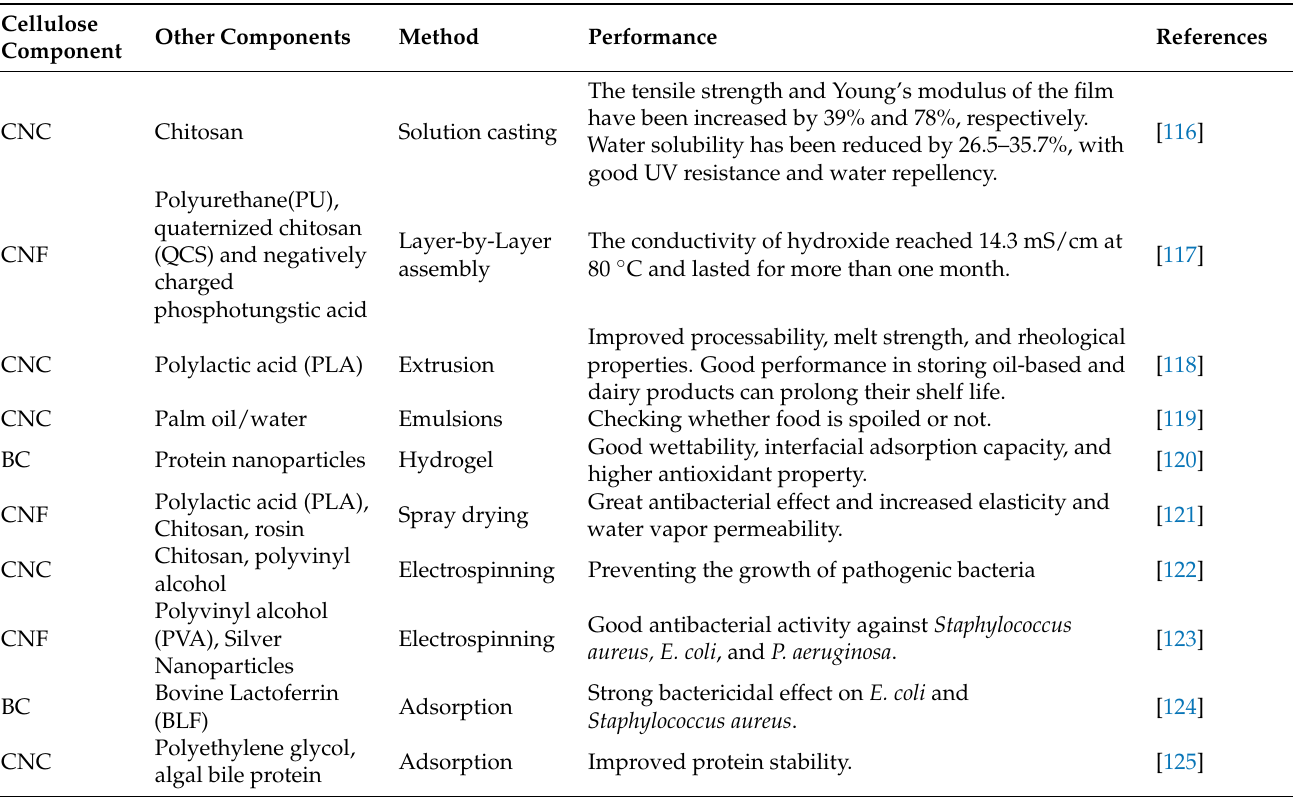
Table 4. Nanocellulose-based composites for food packaging